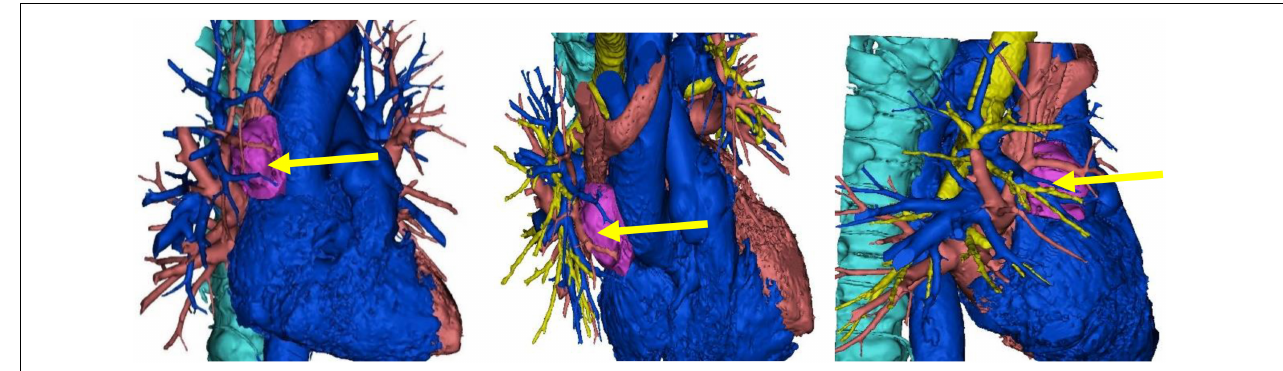
FIGURE 2 | The three-dimensional reconstruction of this mass showing the relative positional relationship between the mass and the surrounding